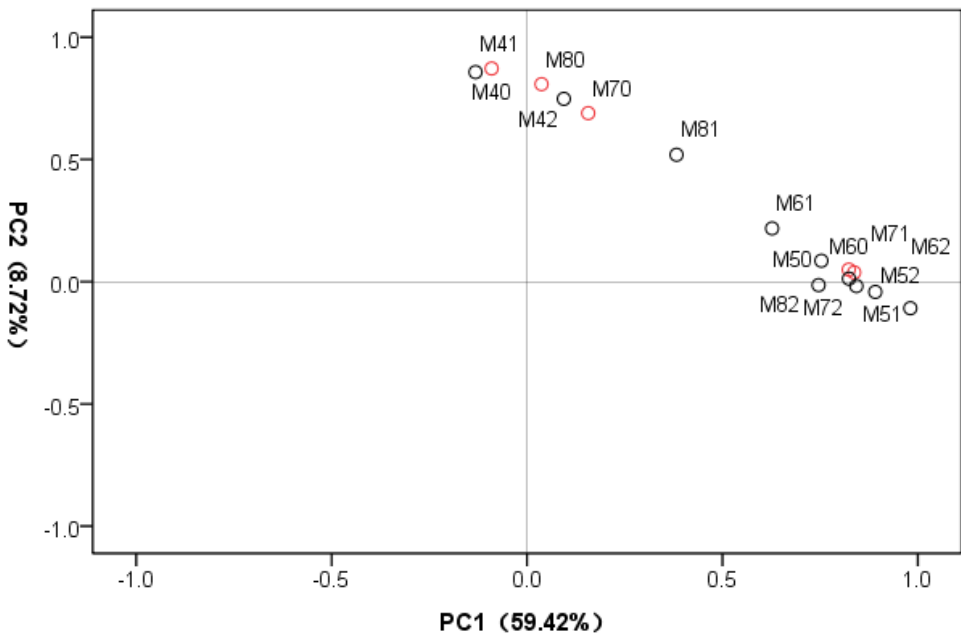
Figure 3. Principle component analysis (PCA) score plot of first and second PCs from 15 mycelial samples. PC1: the first principal component; PC2: the second principal component. Red and black colors represent control and Se-treated samples, respectively.